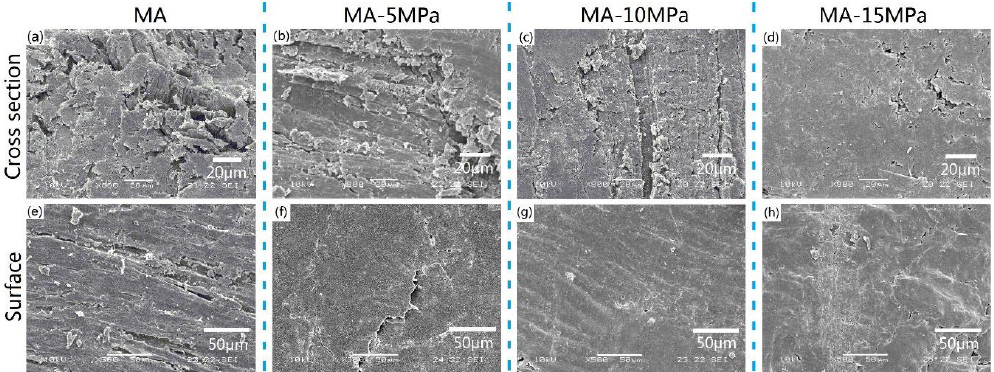
Figure 7. Scanning electron microscopy (SEM) micrographs of the cross section of samples: ( a ) MA, ( b ) MA-5MPa, ( c ) MA-10MPa, ( d ) MA-15MPa and SEM micrographs of the surface of samples: ( e ) MA, ( f ) MA-5MPa, ( g ) MA-10MPa, ( h ) MA-15MPa.